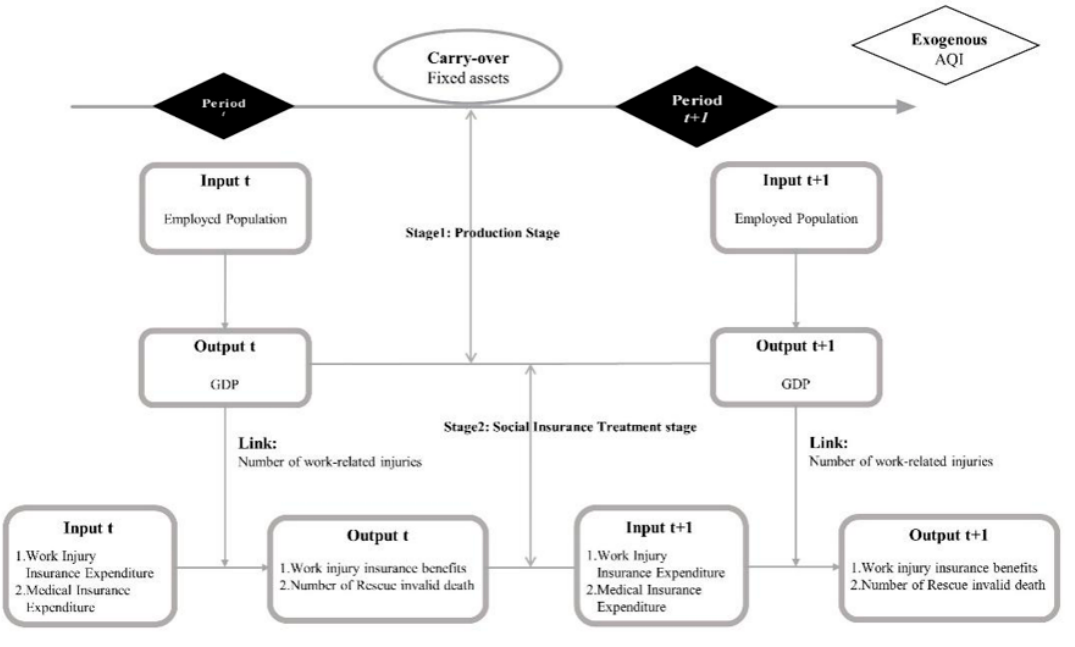
Figure 1. Model framework.